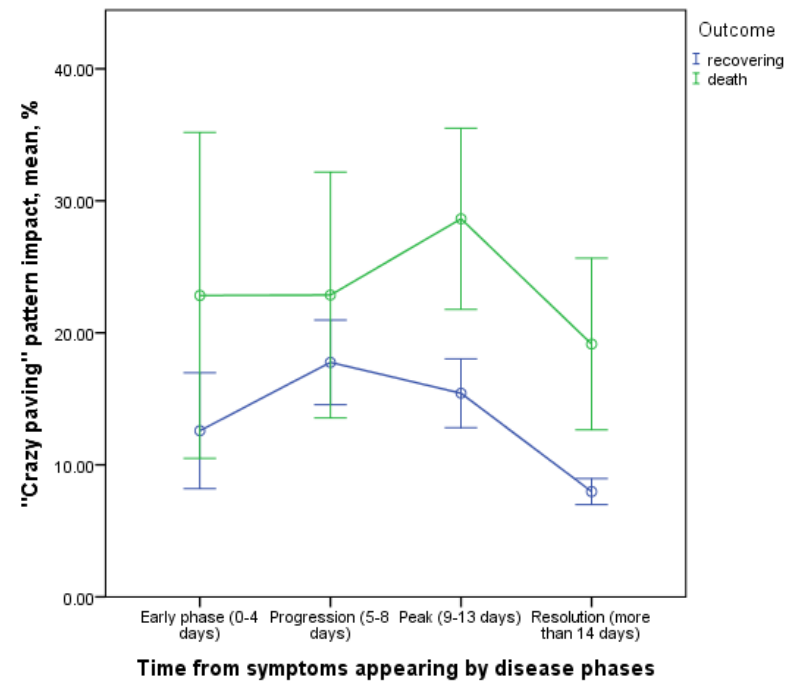
Figure 11. Contribution of the ‘crazy paving’ pattern to CT picture in the affected areas.